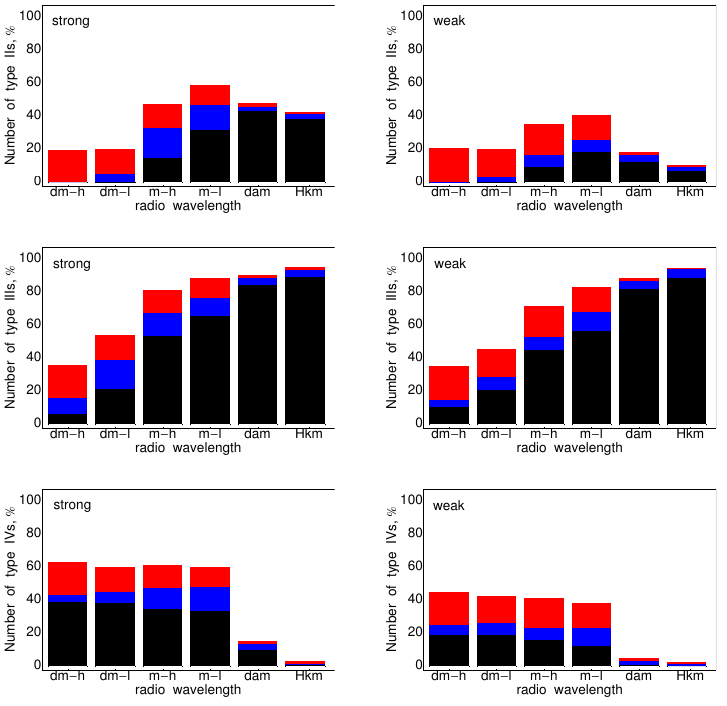
Figure 4. Plots of type II ( top ), III ( middle ) and IV ( bottom ) radio bursts for 416 strong (on the left ), and 416 weak (on the right ) in intensity SEE events. Color code as in Figure